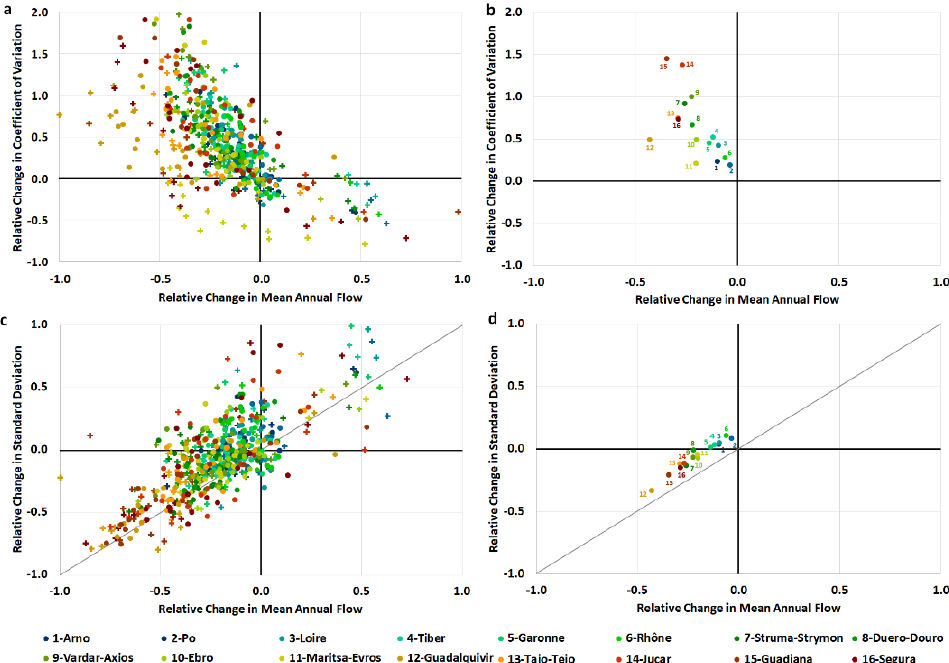
Figure 5. Relative changes in Standard Deviation ( ∆ SD) and Coefficient of Variation ( ∆ CV) of annual flow versus changes in Mean Annual Flow ( ∆ F) for the 16 basins under study. ( a ) ∆ F vs. ∆ SD, all projections; ( b ) ∆ F vs. ∆ SD, mean values; ( c ) ∆ F vs. ∆ CV, all projections; ( d ) ∆ F vs. ∆ CV, mean values.